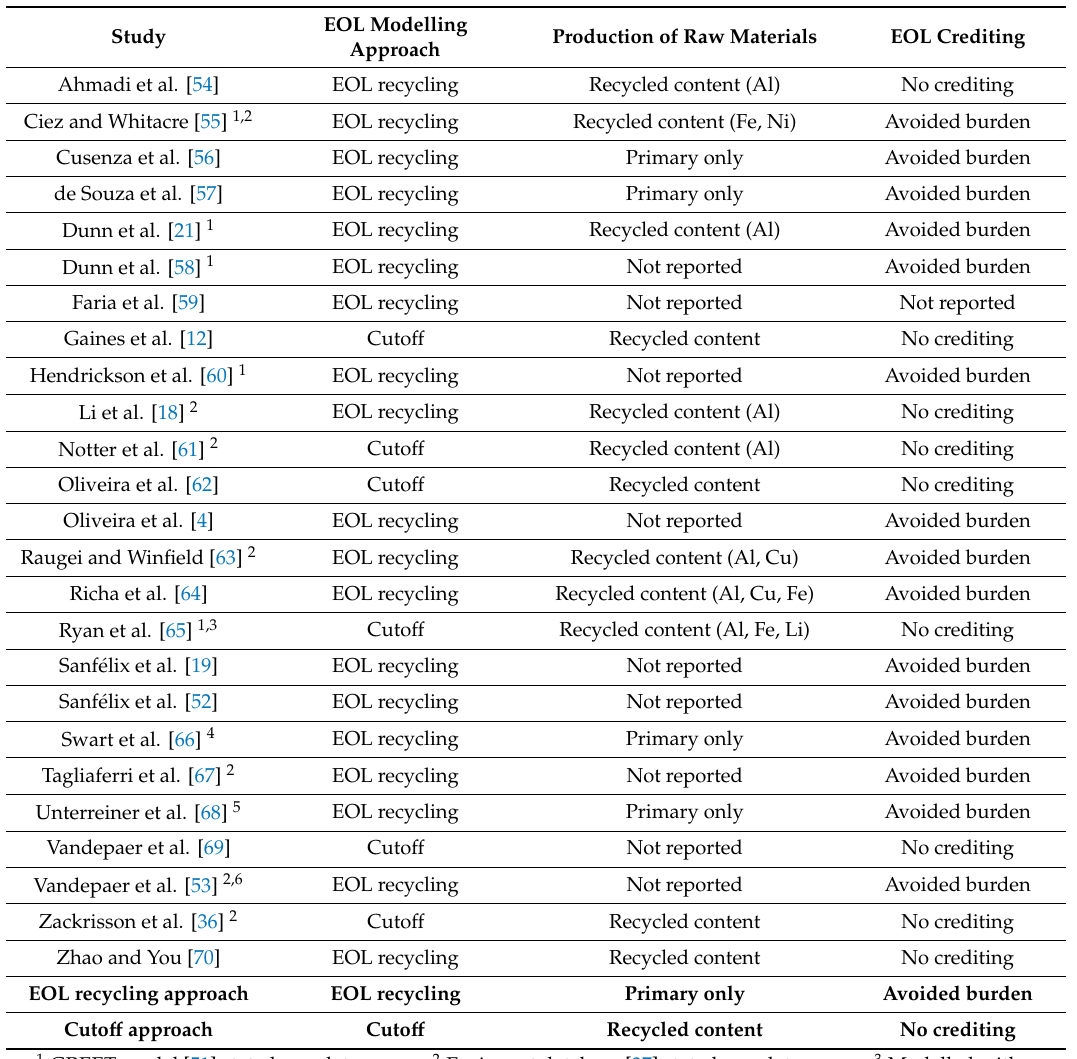
Table 1. Summary of the peer-reviewed articles included in this review, sorted into “EOL recycling” or “cuto ff ” for the EOL modelling approach, “primary only” or “recycled content” for the production of raw materials, and “avoided burden” or “no crediting” for the EOL crediting. Materials having a recycled content are stated in parenthesis when reported in the study. The final two rows show (in bold) the expected study setups in order to be consistent with the two main EOL modelling approach as described in Section